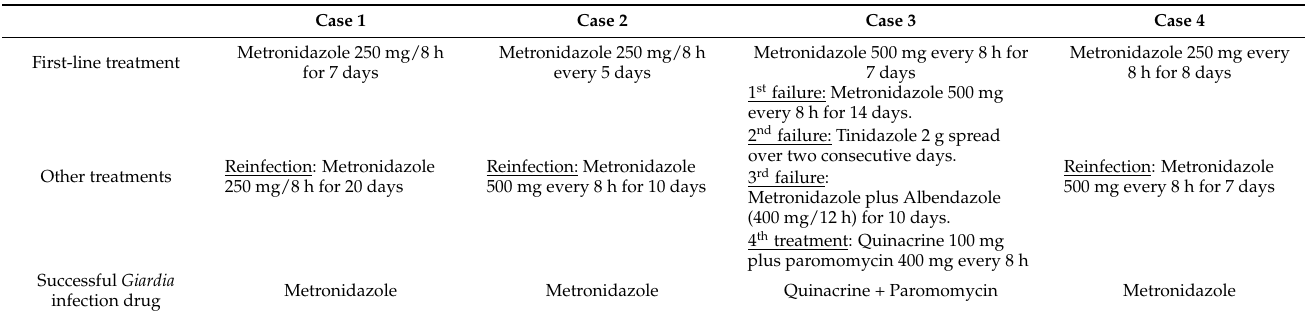
Table 2. Giardia infection treatments in each